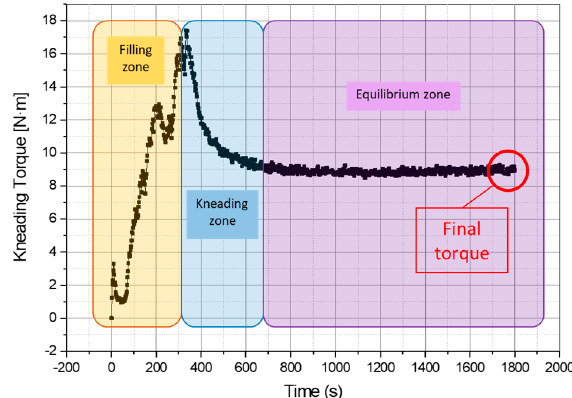
Figure 2. Example of kneading results and three main zones: filling ( left ), kneading ( middle ), and equilibrium ( right ).